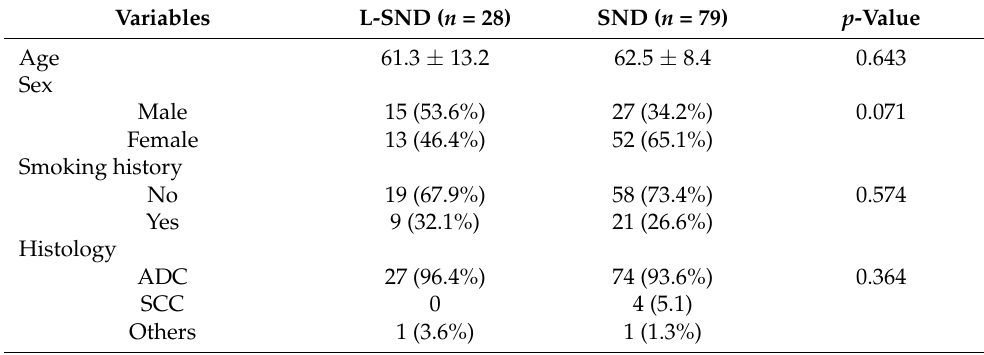
Table 1. Patients’ baseline